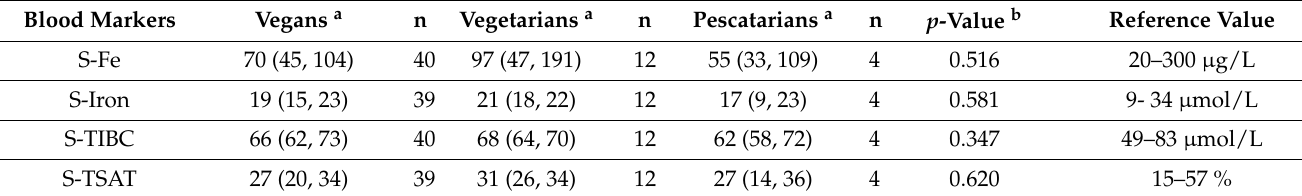
a Values are presented as median (p25, p75), b Test for difference (Kruskal Wallis test), p -value < 0.05 used as significance level. 0.05 used as significance level.